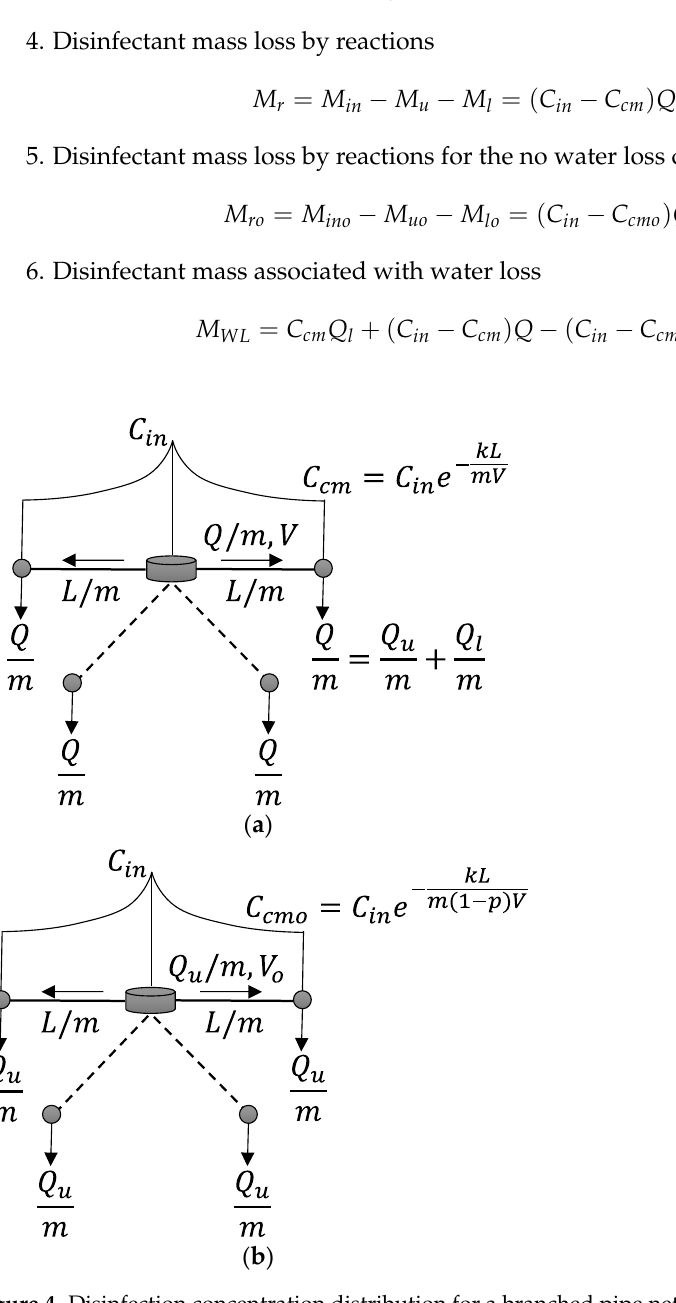
Figure 4. Disinfection concentration distribution for a branched pipe network with demand nodes at the pipe ends, where ( a ) is with water loss and ( b ) is without water loss.